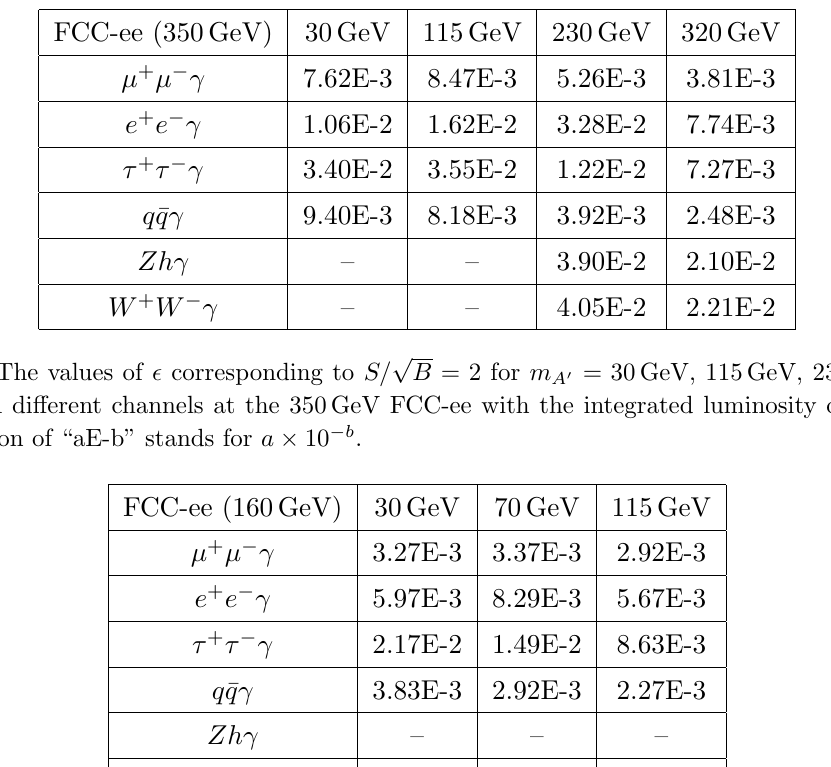
{ W + W (cid:0) (cid:13) { { { p Table 5 . The values of (cid:15) corresponding to S= B = 2 for m A 0 = 30 GeV, 70 GeV and 115 GeV in di(cid:11)erent channels at the 160 GeV FCC-ee with the integrated luminosity of 10 ab (cid:0) 1 . The notation of \aE-b" stands for a (cid:2) 10 (cid:0) b